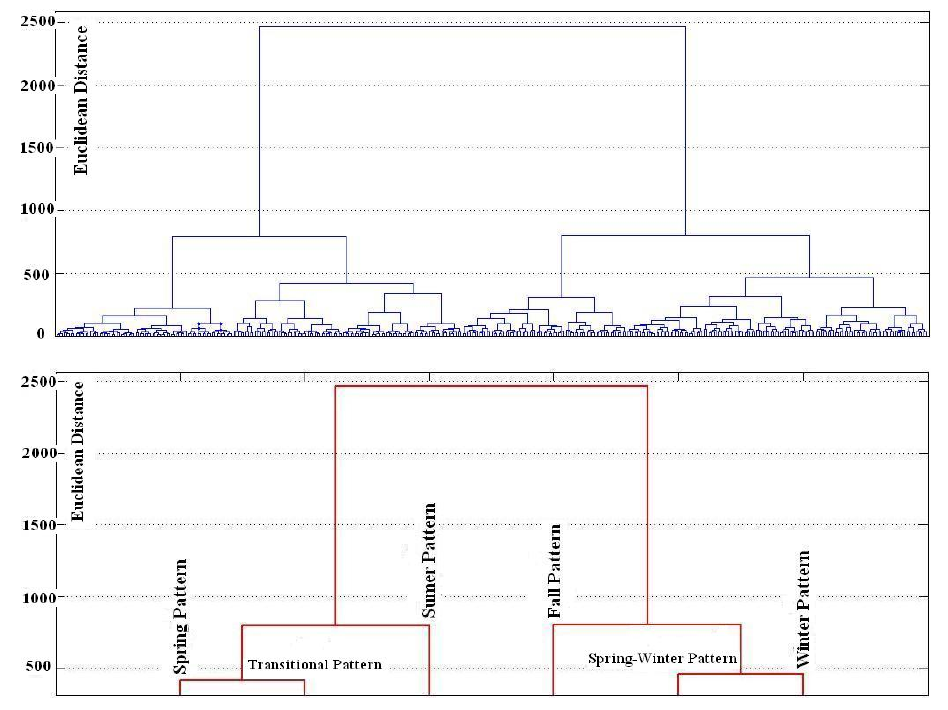
Fig. 2. Cluster Analysis on the Sea Level Pressure Data(Ward Linkage and Euclidean Distance)